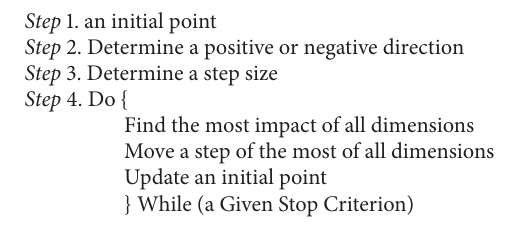
Algorithm 1: The algorithm of the gradient method.